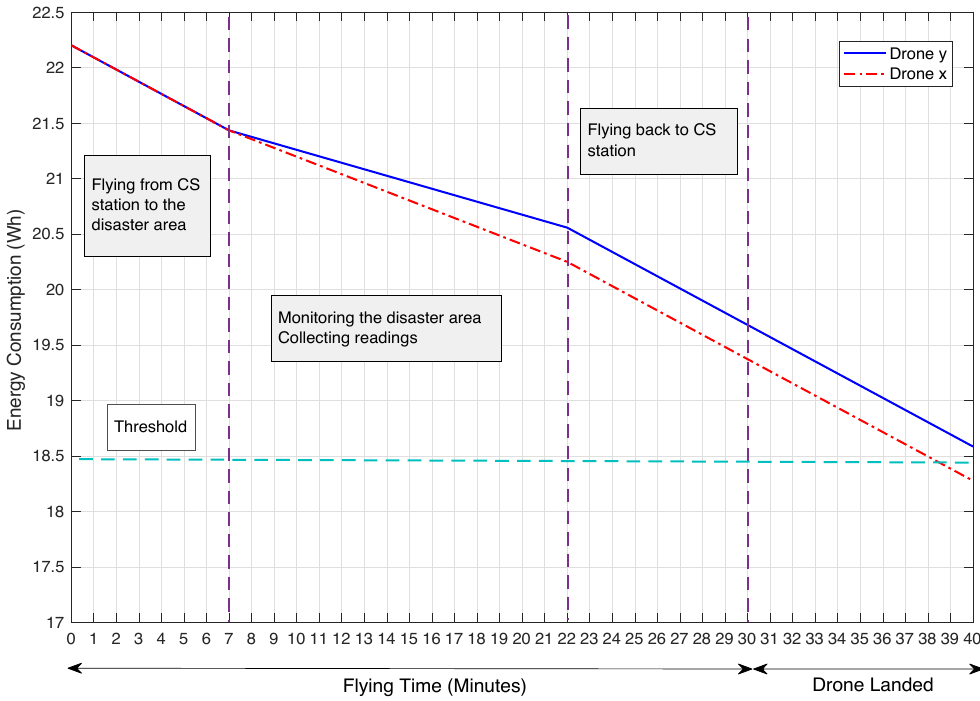
Figure 11. Energy consumption pattern for drone